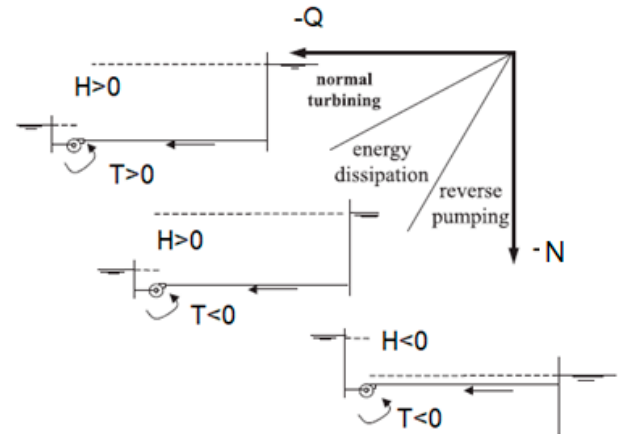
Figure 4. Pump operation zone in the third quadrant and characteristic parameters [34].